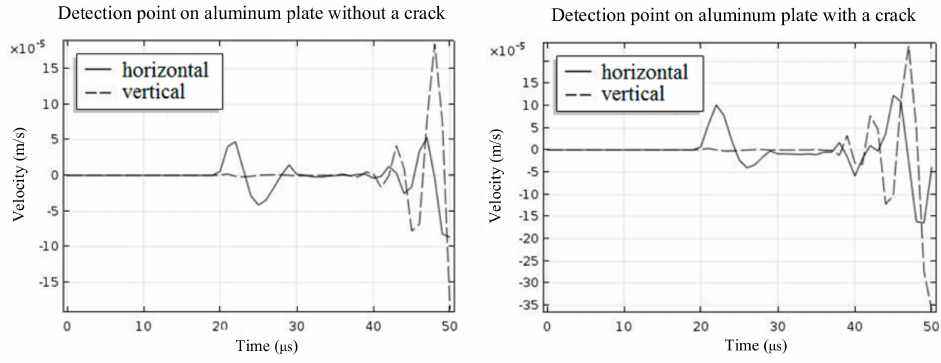
Figure 5. The velocity of detection point on the aluminium plate with and without